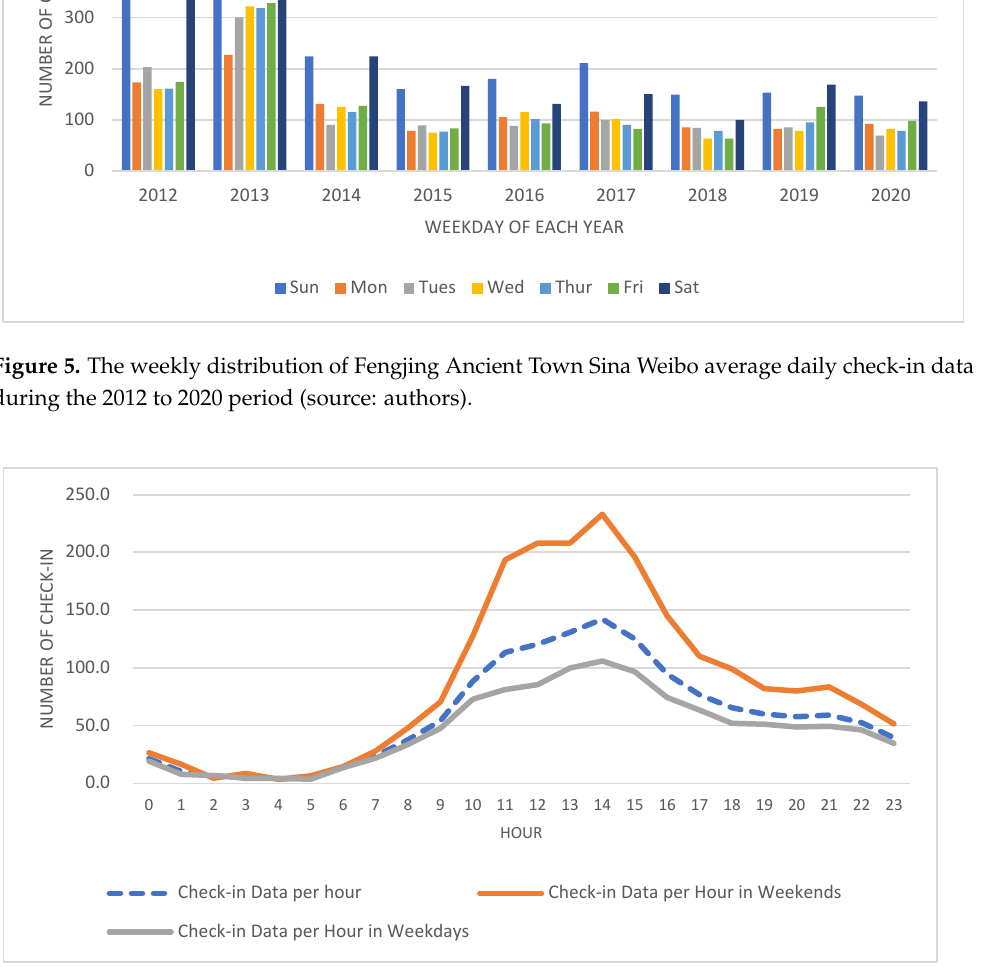
Figure 5. The weekly distribution of Fengjing Ancient Town Sina Weibo average daily check-in data during the 2012 to 2020 period (source: authors).